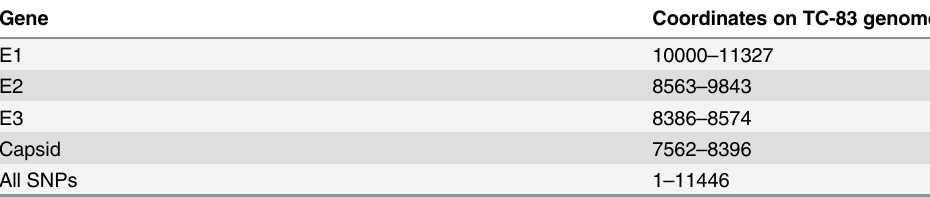
Table 1. Gene regions from which SNPs were